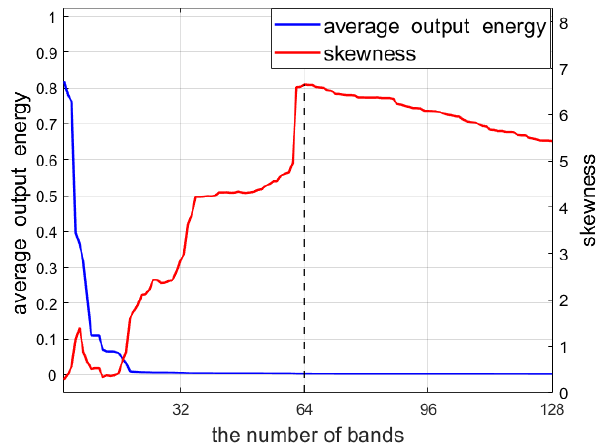
Figure 3. For the Xi’an data with 64 bands, the average output energy and the skewness curves as a function of L , ranging from 2 to 128, where the last 64 bands are noisy ones. (The black vertical dotted line corresponds to the data with full bands ( L = 64), after which the noisy bands with Gaussian distribution are added. It can be seen that the skewness value at L = 64 is the